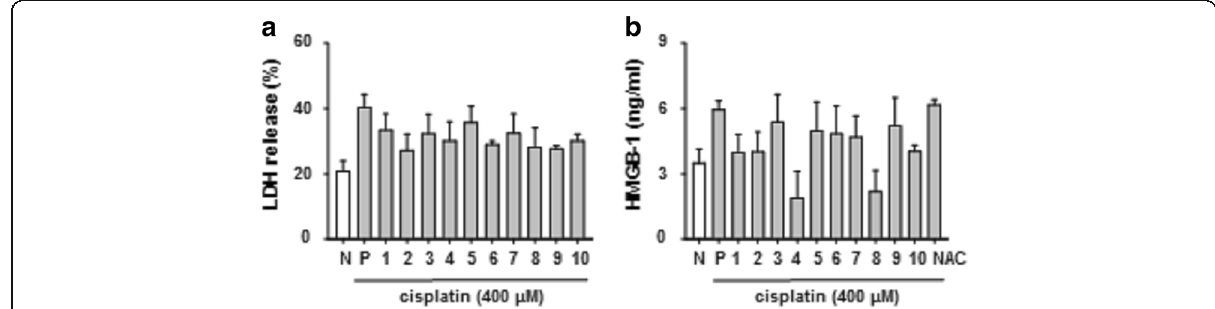
Fig. 3 HMGB1 was regulated by herbal medicines with high dose-treated cisplatin in HK-2 cells. HK-2 cells were treated with high – dose of cis- platin (400 μ M) for 6 h. Herbal medicines decreased LDH ( a ), and HMGB1 ( b ). The levels of LDH, HMGB1 were measured by ELISA assay kits